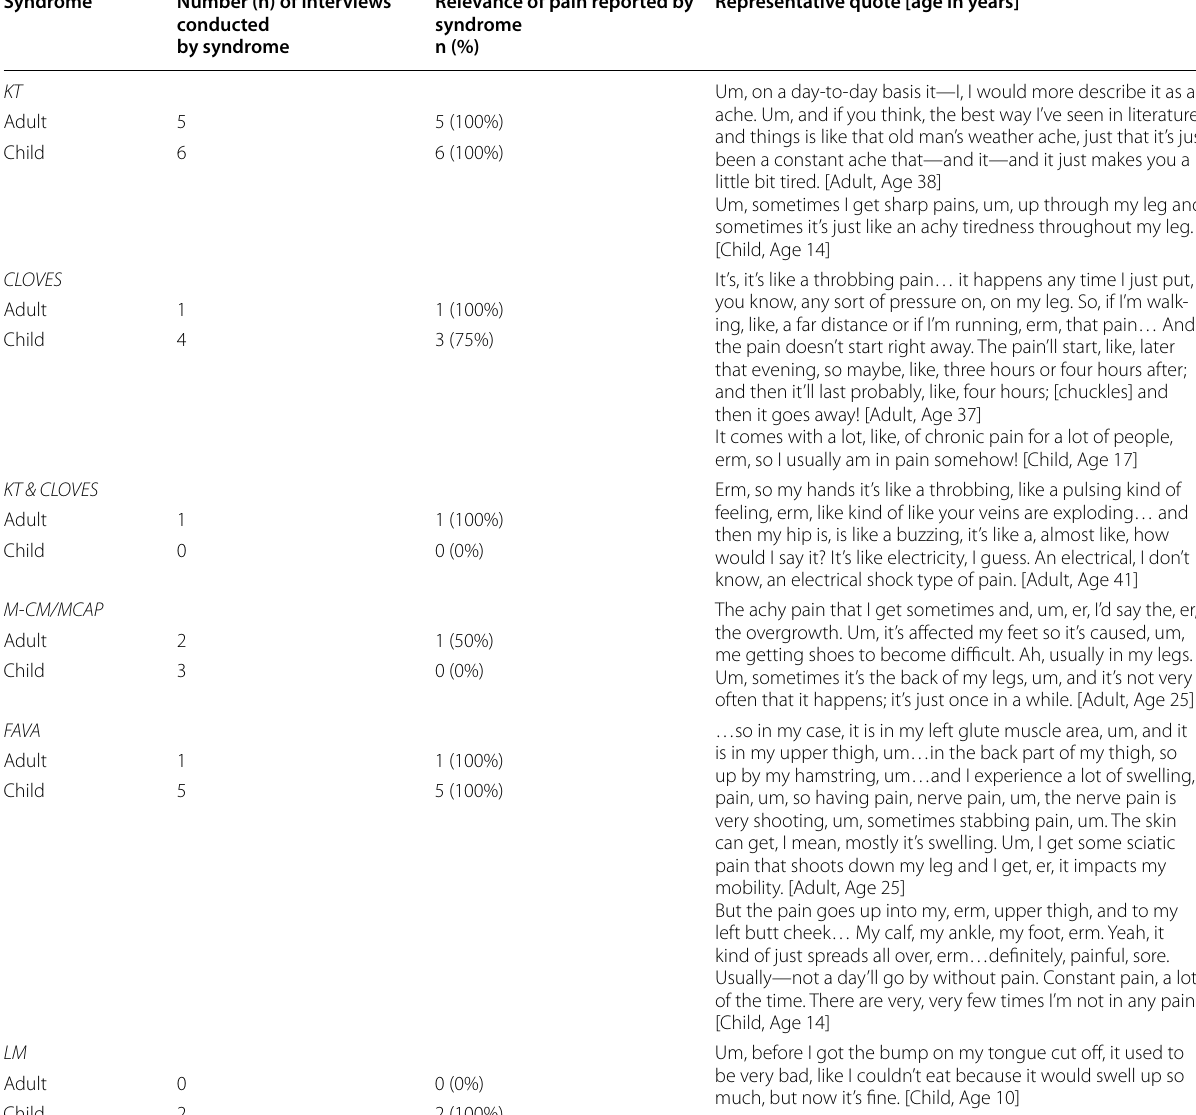
Table 6 Relevance and experience of pain for adult and child participants by syndrome Syndrome Number (n) of interviews